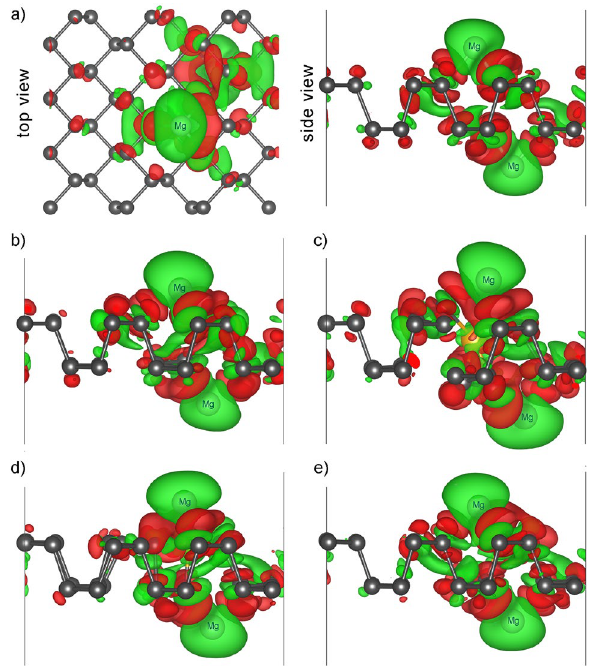
Figure 6. The charge difference plots of two Mg atoms adsorbed on ( a ) pristine BP, ( b ) B-, ( c ) Sc-, ( d ) Co-, and ( e ) Cu-doped phosphorene The loss of electrons is indicated in green and gain of electrons is indicated in red. 3 a 0 is the Bohr The isosurface level was set at 0.0007 a − 0 , where